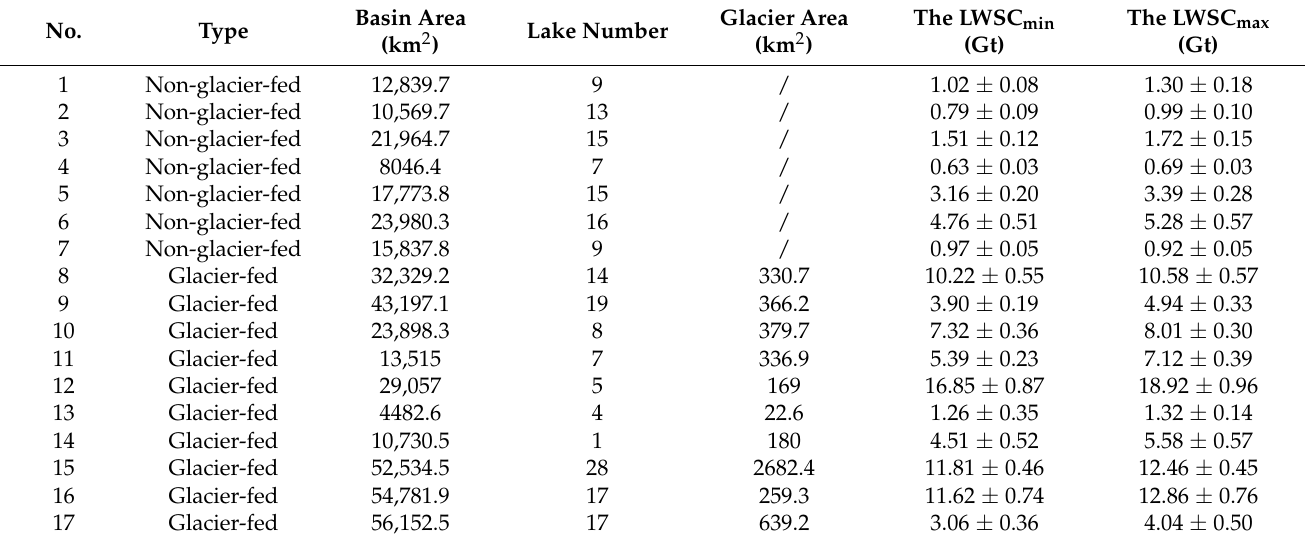
Table 2. The LWSC of glacier-fed lakes and non-glacier-fed lakes in the inner TP from 2000 to